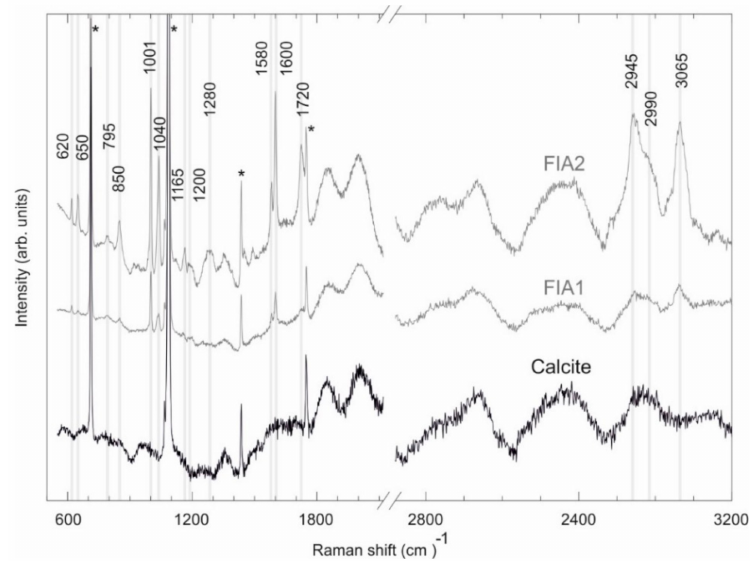
Figure 7. Raman spectra of the studied bladed calcite and FIA1 and FIA2. Main vibrations are given in cm − 1 . The assignment of the observed Raman peaks for FIA1 and FIA2 is given in Table 1. Raman peaks highlighted with * indicate the main vibrations of calcite.